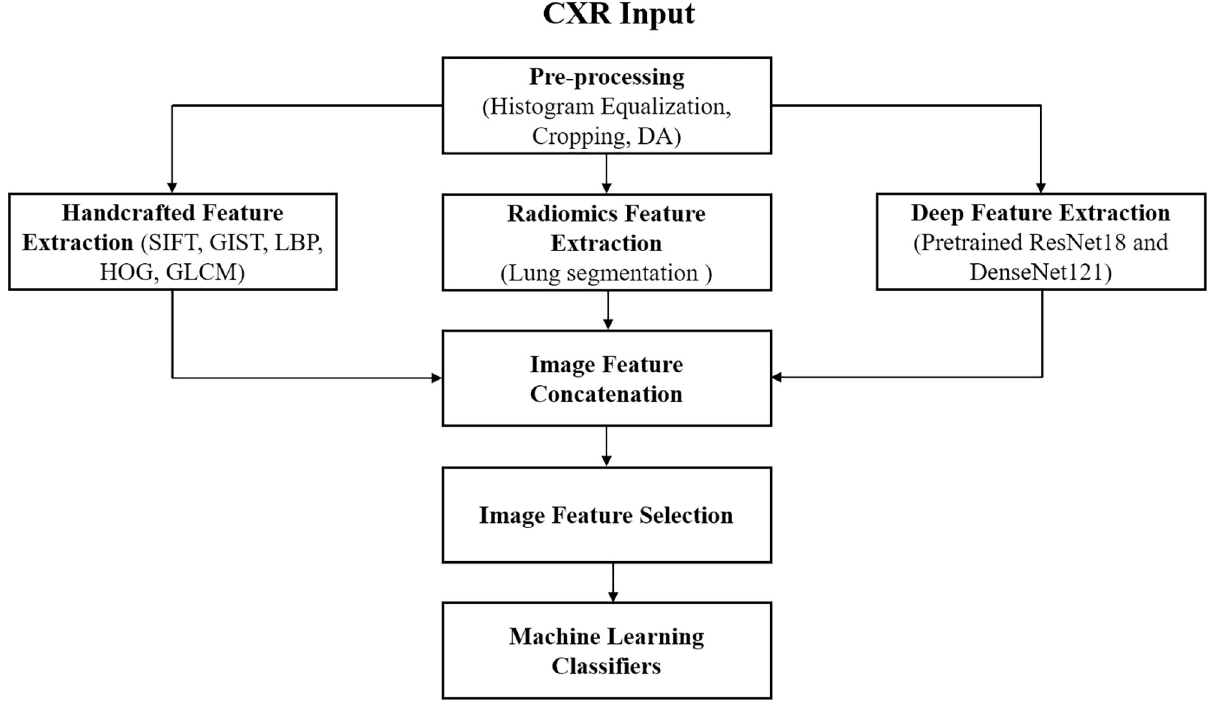
Fig 1. Overview of the proposed method for our COVID-19